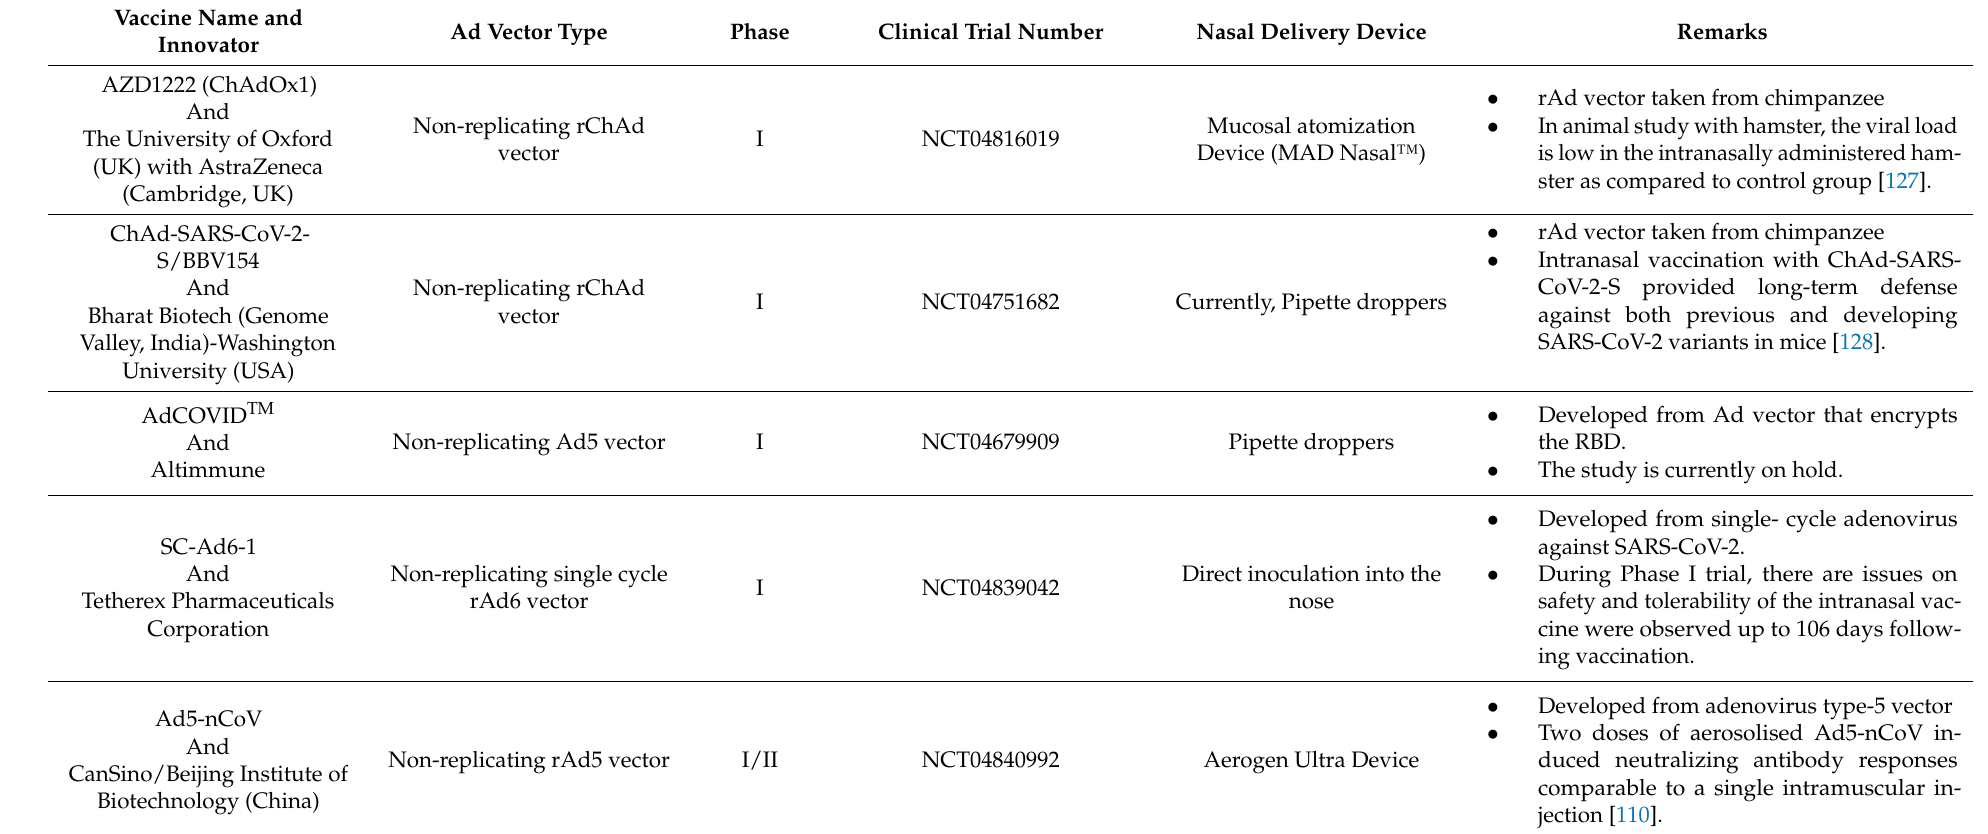
Table 2. Intranasal vaccine for COVID-19 under development based on Ad vector